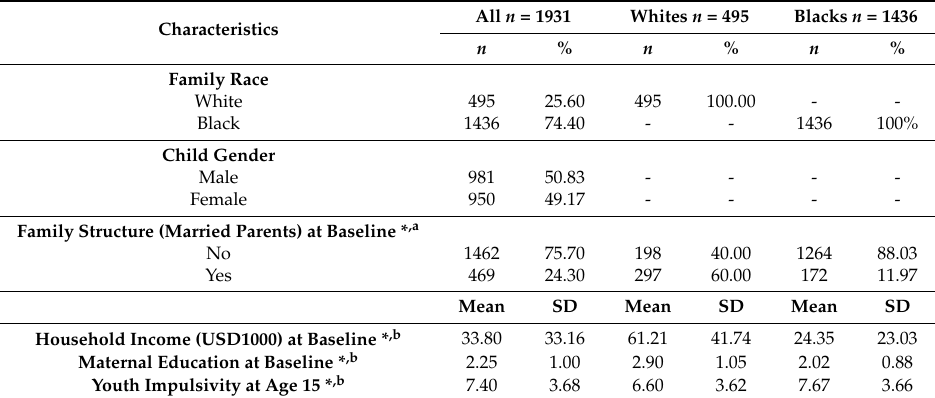
Table 1. Descriptive statistics in the overall sample and by race ( n =